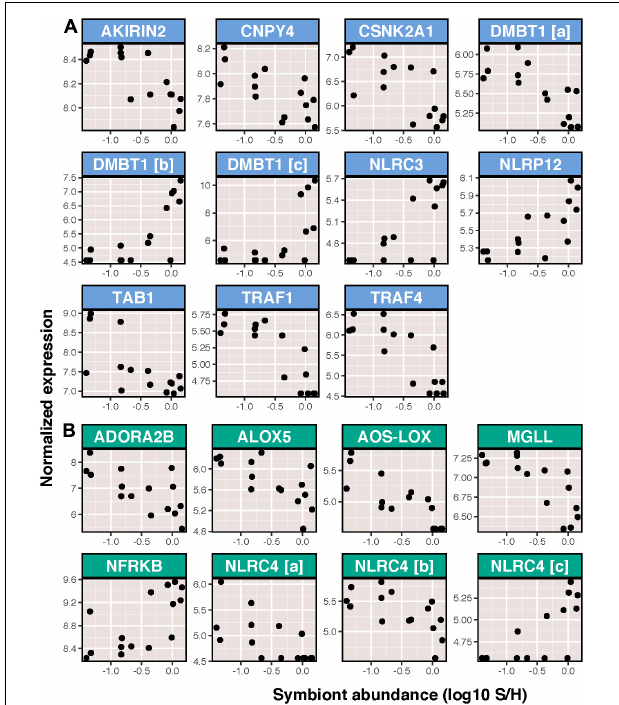
FIGURE 4 | Symbiont abundance vs. variance stabilized normalized expression of significantly differentially expressed transcripts with functions related to or downstream of (A) toll like receptor signaling and (B) inflammation. Genes are listed in alphabetical order. Those displayed are: (A) akirin-2, protein canopy homolog 4 (CNPY4), casein kinase II subunit alpha (CSNK2A1), deleted in malignant brain tumors protein 1 (DMBT1), protein NLRC3, NACHT, LRR, and PYD domains-containing protein 12 (NLRP12), TGF-beta activated kinase 1 (TAB1), TNF-receptor associated factor 1 (TRAF-1), and TNF-receptor associated factor 4; (B) adenosine receptor A2b (ADORA2b), arachidonate 5-lipoxygenase (ALOX5), allene oxide synthase-8R-lipoxygenase (AOS-LOX), monoglyceride lipase (MGLL), nuclear factor related to kappa-B binding protein (NFRKB), and NLR family CARD domain-containing protein 4